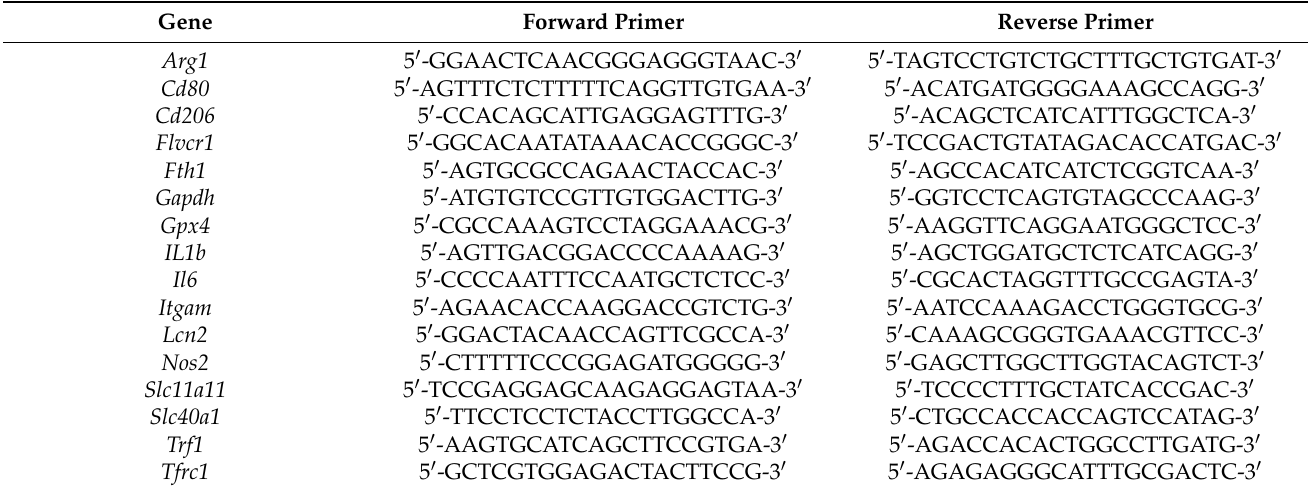
Table 1. Murine gene primers for qPCR.